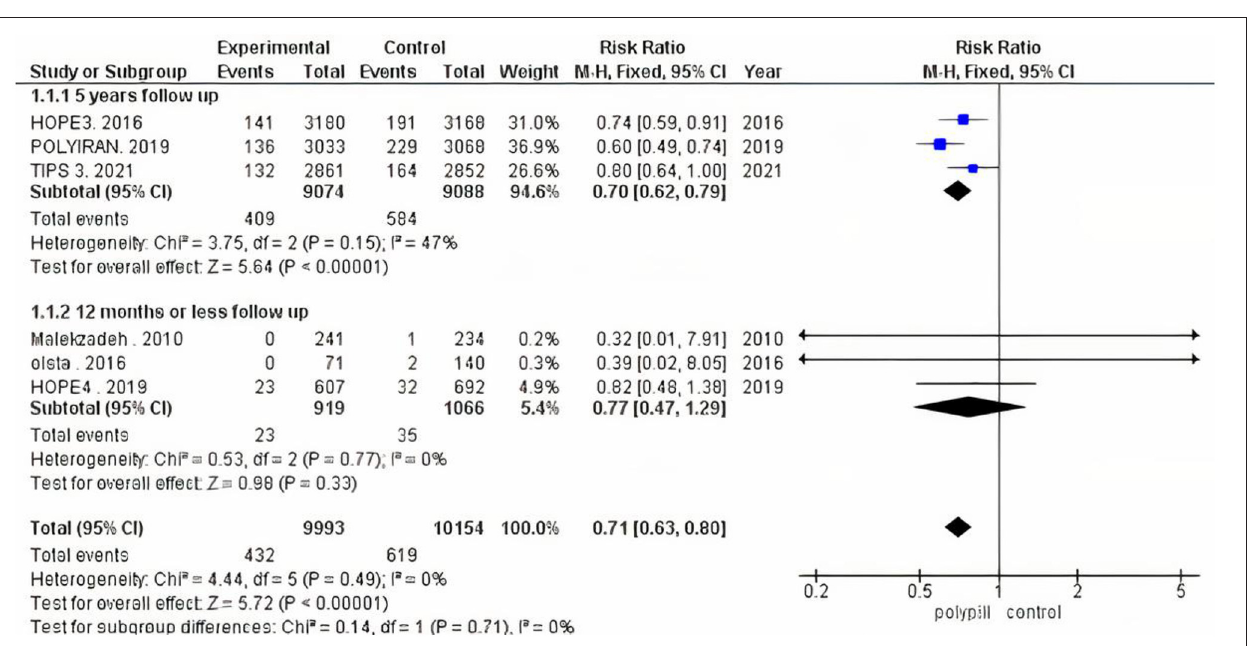
FIGURE 4 | Forest plot of the 12-months-or-less and 5-year follow-up subgroup